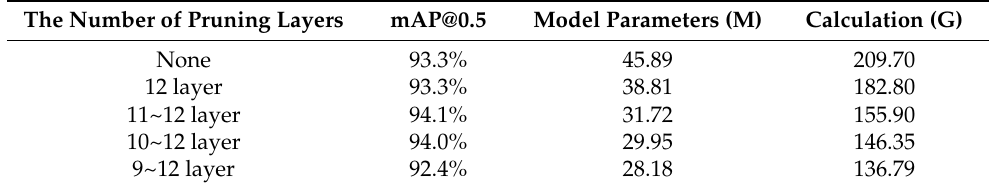
Table 3. Accuracy, model parameters and calculation of the Swin-T YOLOX model for multi-layer pruning of the Swin Transformer network.